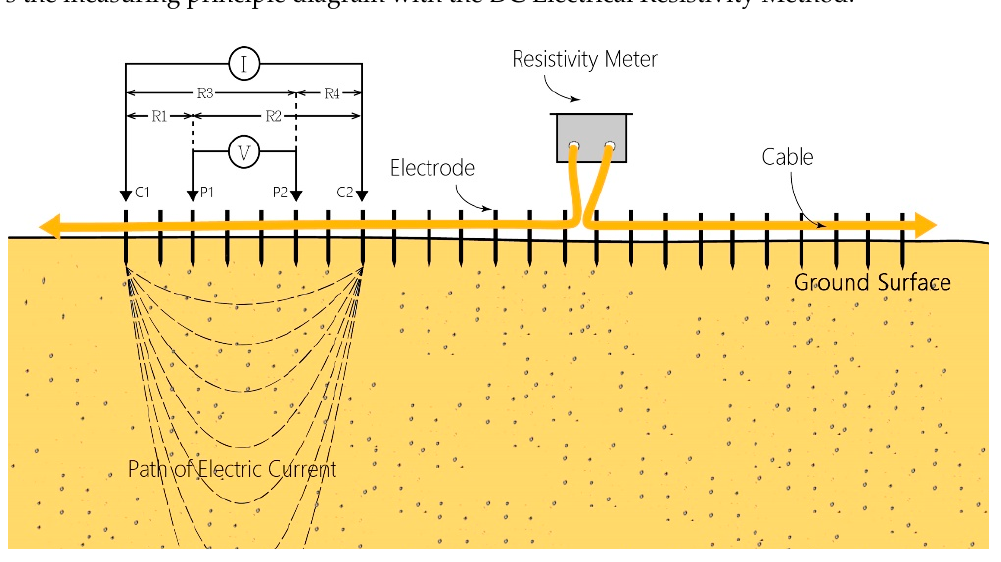
Figure 2. Schematic diagram for detection with the DC Resistivity method.